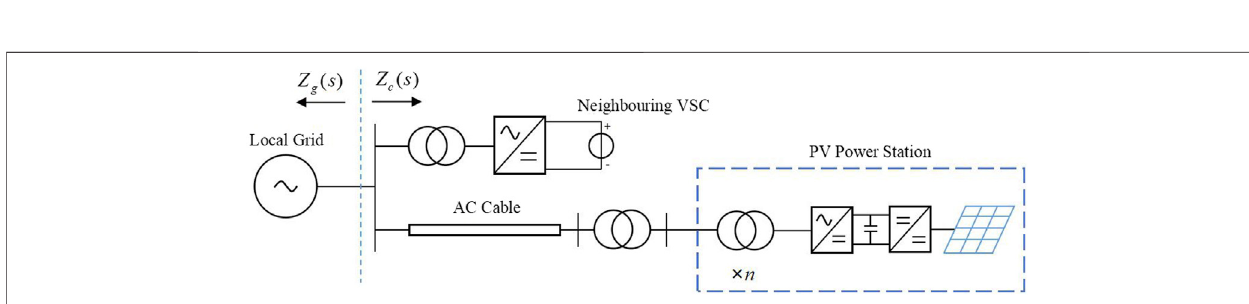
FIGURE 3 | Schematic diagram of the voltage source and current source in the internal stability analysis.